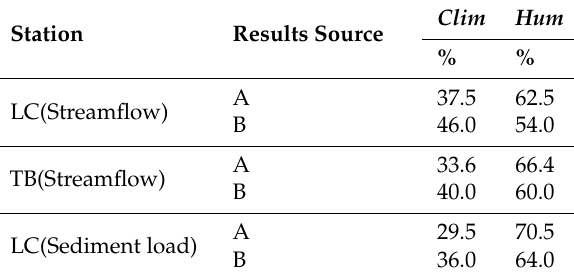
Table 7. Comparison with previous research.